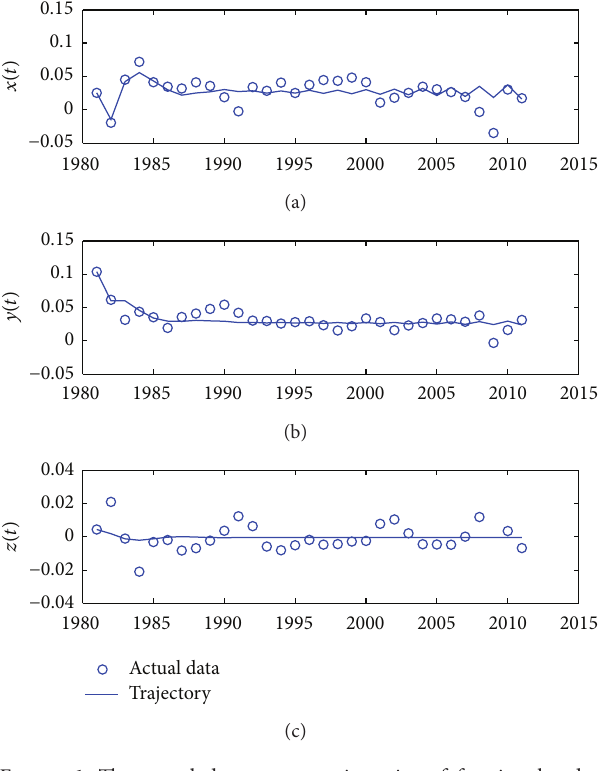
Figure 1: The actual data versus trajectories of fractional-order system in each dimension about